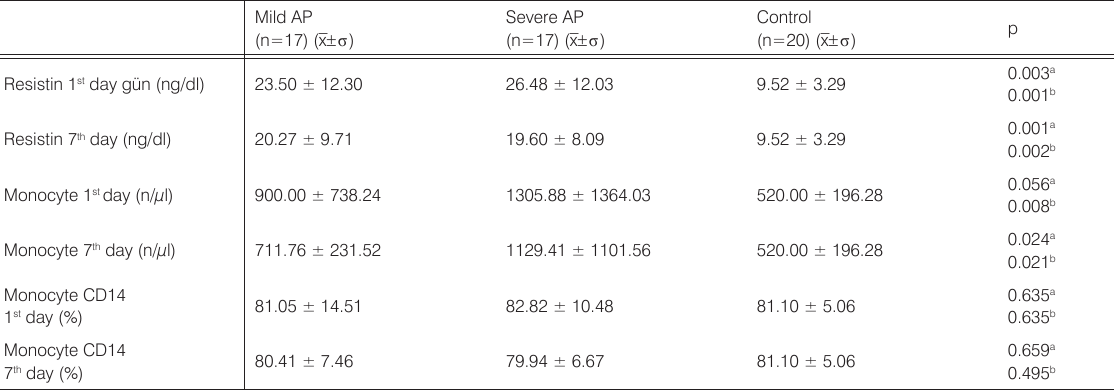
Table 3. The mean serum resistin, monocyte, and monocyte CD14 levels of the mild and severe AP and control groups.